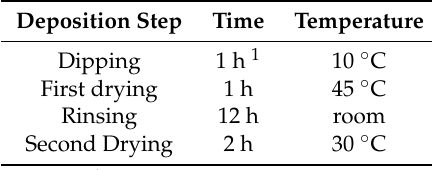
Table 1. Fabrication step details of the previous deposition procedure.